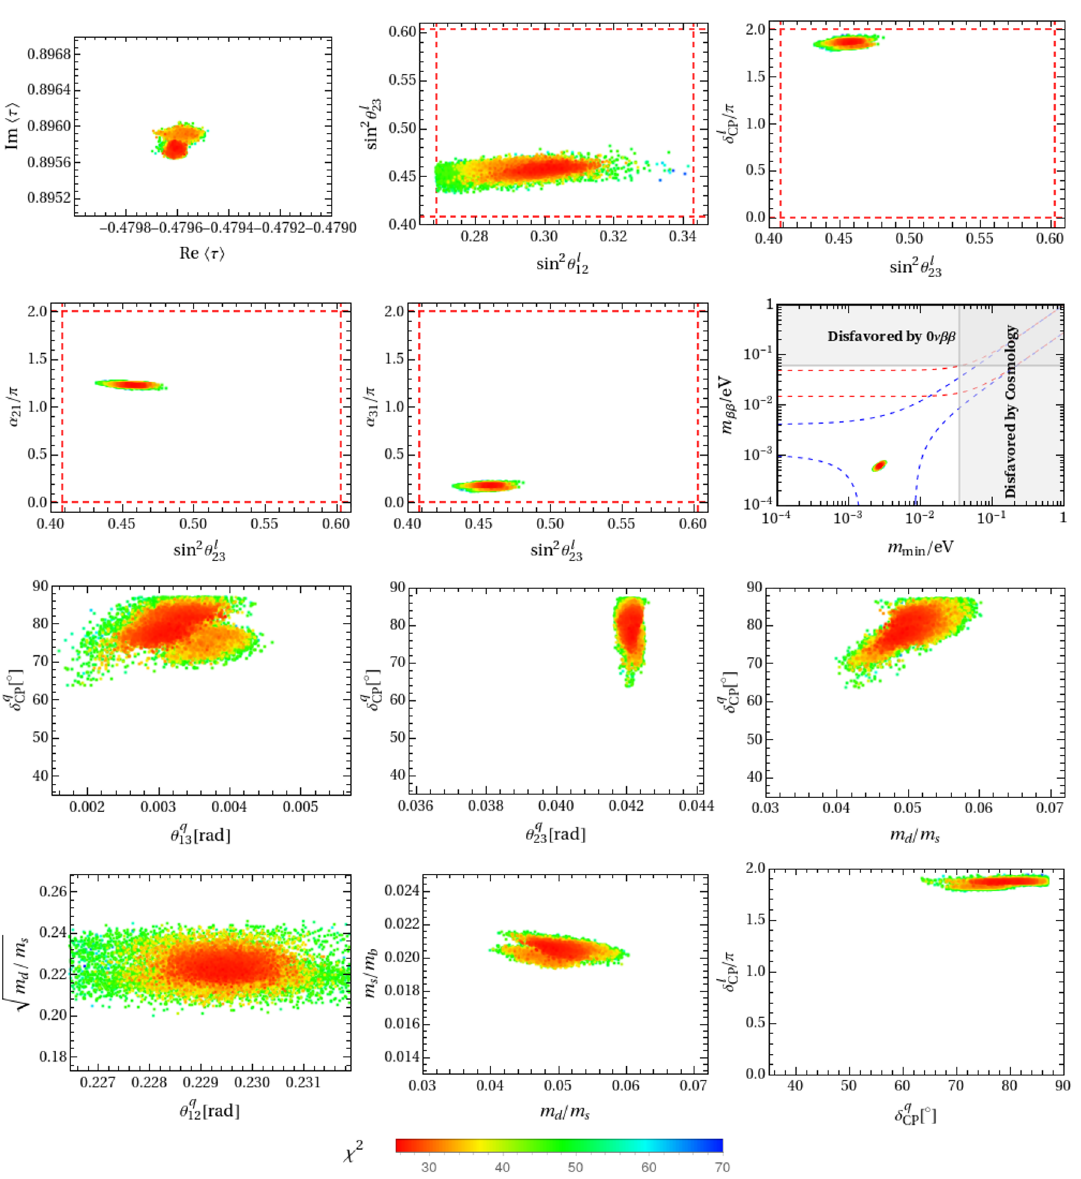
Figure 4 . The values of the complex modulus τ compatible with experimental data and the correlations between the neutrino mixing angles, CP violation phases, quark mass ratios and mixing parameters for the model BM2 with vanishing initial condition. The vertical and horizontal dashed lines are the 3 σ bounds taken from [110]. Note that the contribution of Y B to χ 2 is not included